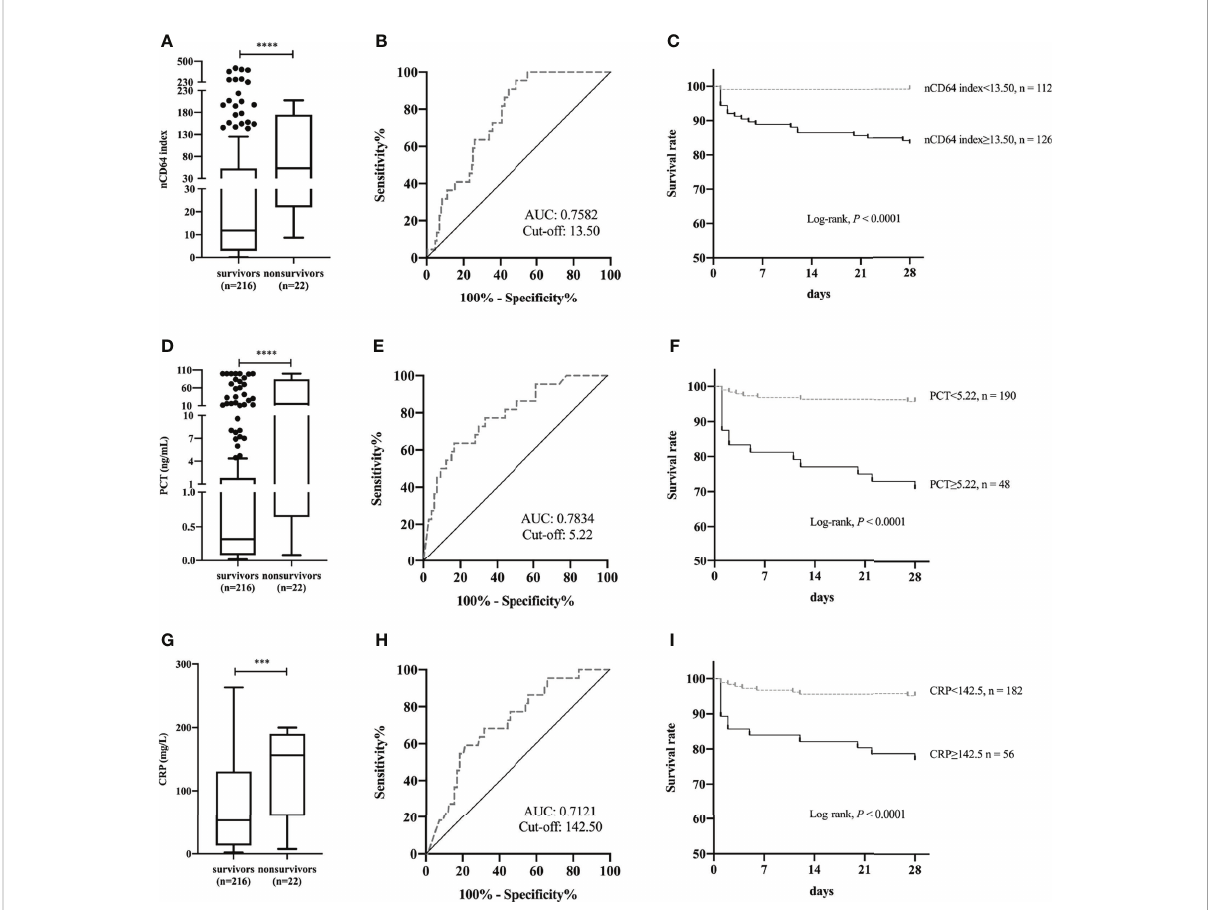
FIGURE 5 Comparison of nCD64 index (A) , PCT (D) , and CRP (G) between 28-day hospital survivors and non-survivors. The ROC curves analysis of nCD64 index (B) , PCT (E) , and CRP (H) for predicting 28-day hospital death. Kaplan-Meier survival curves for patients with the best cut-off value of nCD64 index (C) , PCT (F) , and CRP (I) , compared using log-rank test. *** P <0.001, **** P <0.0001. nCD64, neutrophil CD64; PCT, procalcitonin; CRP, C-reactive protein; ROC, receiver operating characteristics; AUC, area under the